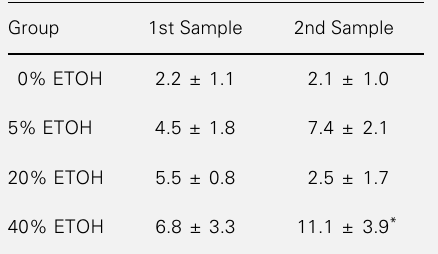
Table 2 - Plasma alcohol levels of tail artery samples withdrawn 2-4 h and 10-12 h after offer- ing the alcohol solution. Data are reported as means ± SEM (mg/dl). *P<0.01 compared to 0% ETOH (Student t -test of least square